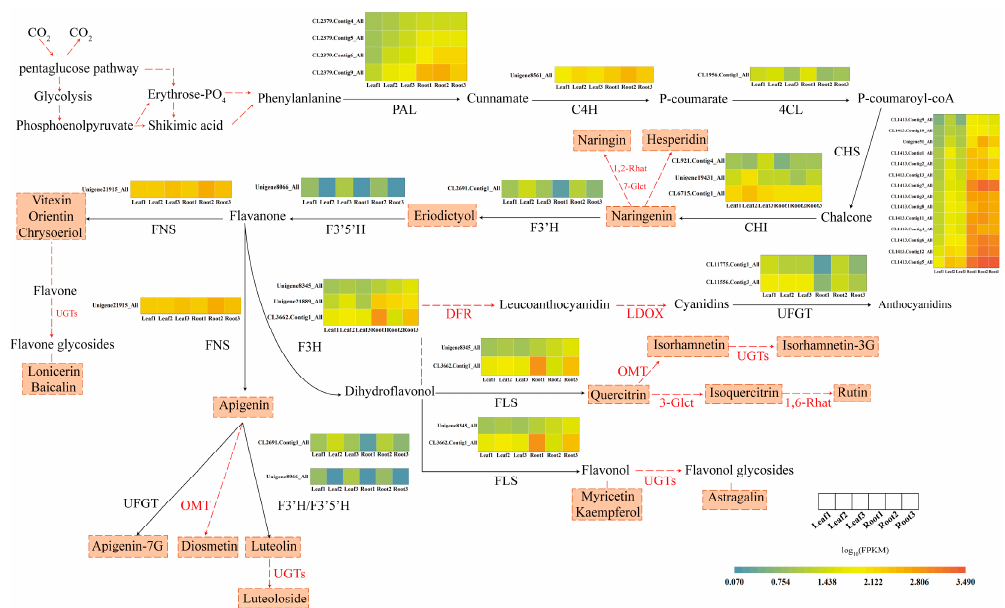
Figure 6. Biosynthetic pathway of flavonoids [16–21]. This pathway contains the major flavonoid metabolites and the expression of synthetases. The ingredients in the dotted box are the